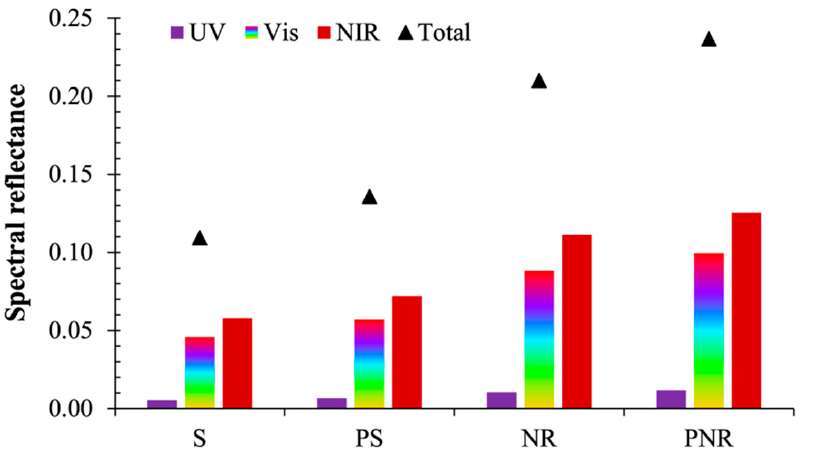
Figure 7. UV-Vis-NIR reflectance.